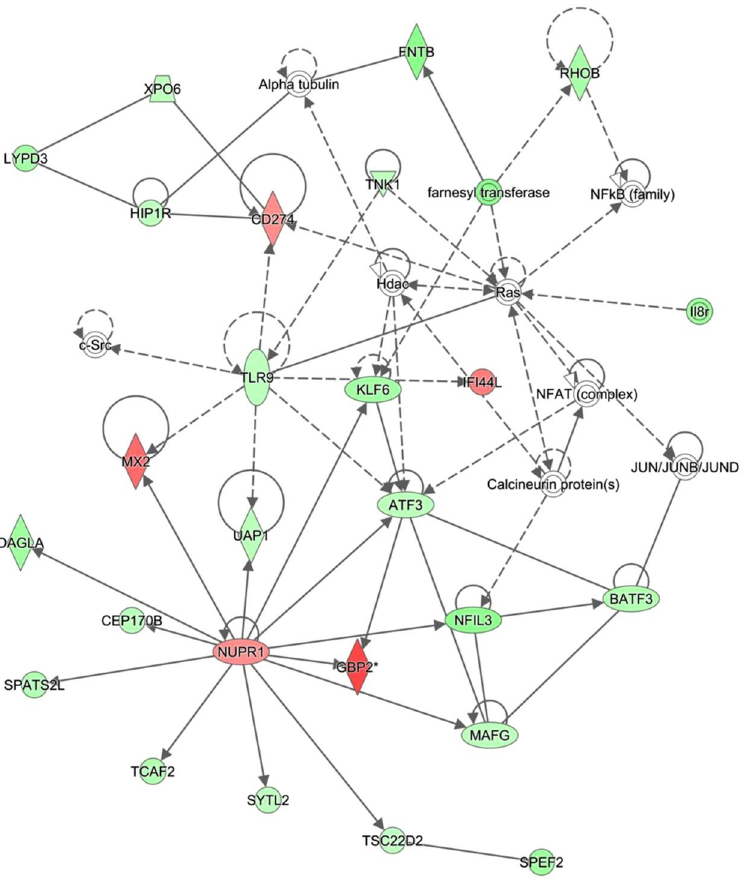
Figure 1. Immunological disease and Infectious disease network enriched in comparison of Dairy 48 h v Dairy 0 h. Network 2- Immunological Disease, Infectious Diseases, Organismal Injury and Abnormalities network enriched in comparison of dairy 48 h to 0 h. The network is displayed graphically as nodes (genes). The node colour intensity indicates the expression of genes; with red representing up-regulation and green, down- regulation in 48 h dairy calves compared to 0 h dairy